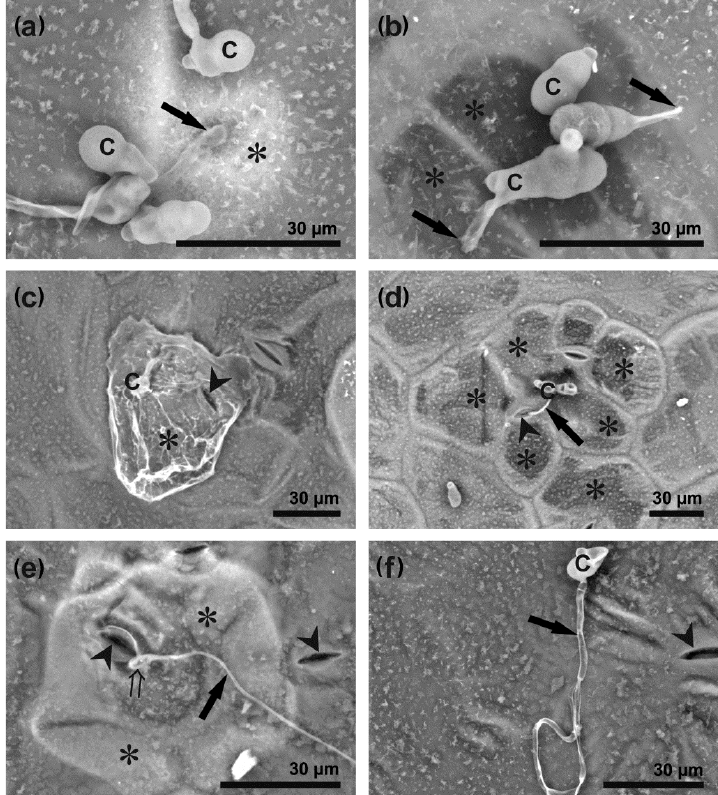
Figure 3. Alternaria brassicicola penetration modes and different host cell reactions. The images were capture using SEM at 24 hpi. ( a ) a bright ‘halo’ (asterisk) around the appressorium (arrow) penetrating the host cell; ( b ) direct penetration (arrows) caused a collapse of epidermal cells (asterisks) underneath germinating conidia; ( c ) dissolved wax layer (asterisk) around germinating conidium (arrowhead points to stoma); ( d ) germination tube (arrow) entering the leaf via stoma (arrowhead) surrounded by collapsed epidermal cells (asterisks); ( e ) germination tube (arrow) forming an appressorium (double tail arrow) over stoma (arrowhead). Neighboring epidermal cells (asterisks) have fortified cell walls; ( f ) symptomless growth of hypha (arrow) on leaf surface (arrowhead points to stoma). Abbreviation: